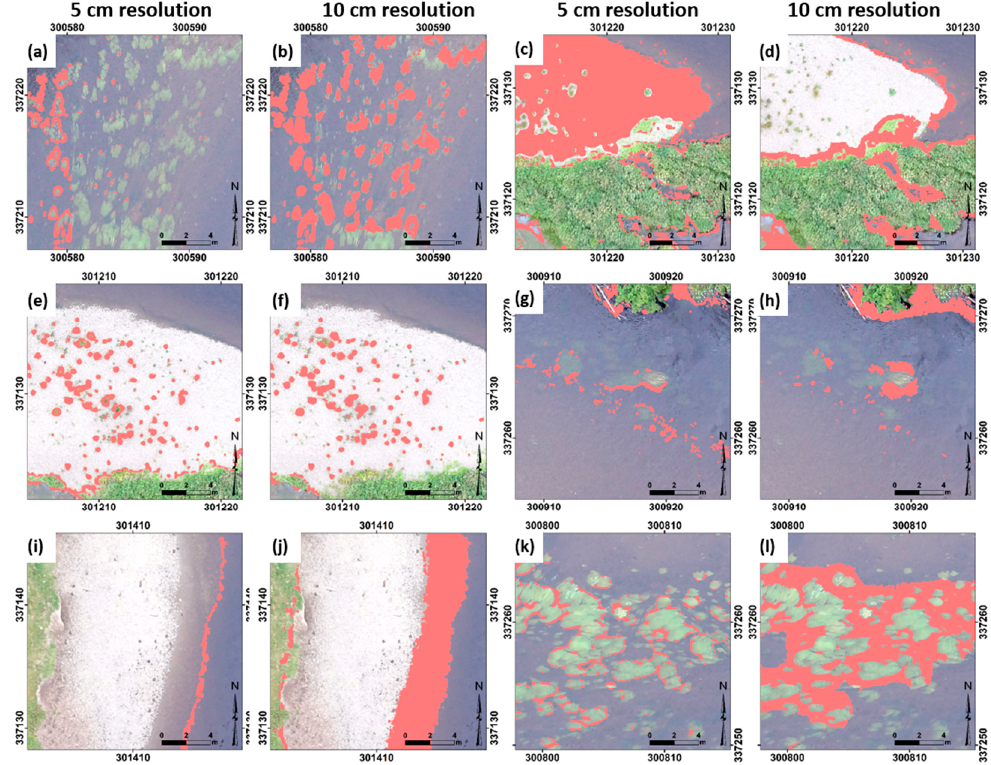
Figure 6. Images showing the mismatch in class feature identification between the 2.5 cm resolution and the 5 cm and 10 cm resolutions. Pixels highlighted in pink show those locations where the 2.5 cm resolution classification identified: ( a , b ) vegetation; ( c , d ) side bar; ( e , f ) vegetation; ( g , h ) deep water; ( i , j ) side bar; and ( k , l ) shallow water, and the coarser resolutions were a mismatch. Table 6. Percentage of pixels at 5 cm and 10 cm resolution that present hydromorphological classification equal to that identified for the 2.5 cm resolution orthoimage. The codes used for each of the features are as follows: side bar (SB), erosion (ER), riffle (RI), deep water (DW), shallow water (SW), shadow (SH) and vegetation (VG).